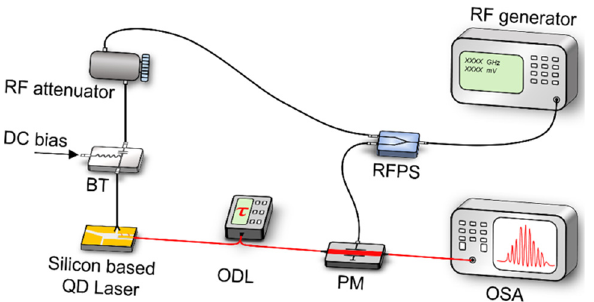
Figure 9. Schematics of the experimental set-up of optical phase modulation method. RFPS, radio- frequency power divider; BT, bias tee; ODL, optical delay line; PM, phase modulator; OSA, optical spectrum analyzer.